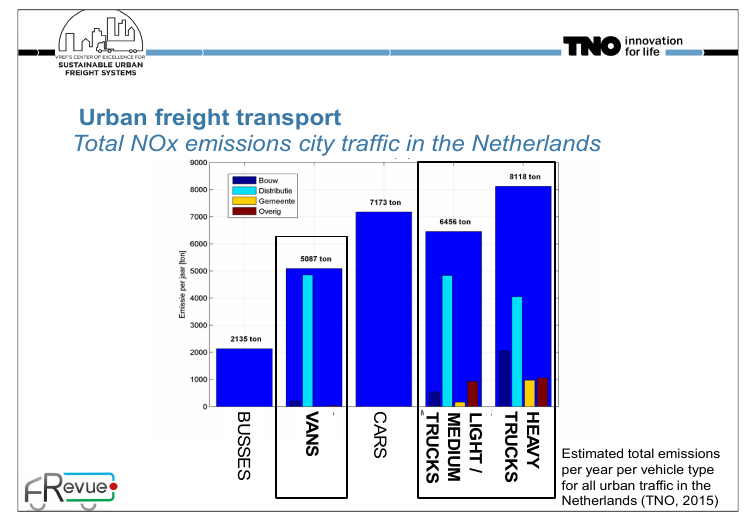
Figure 8. NO x emissions from trucks, cars, vans, and buses in the Netherlands. Reproduced with permission from [23].